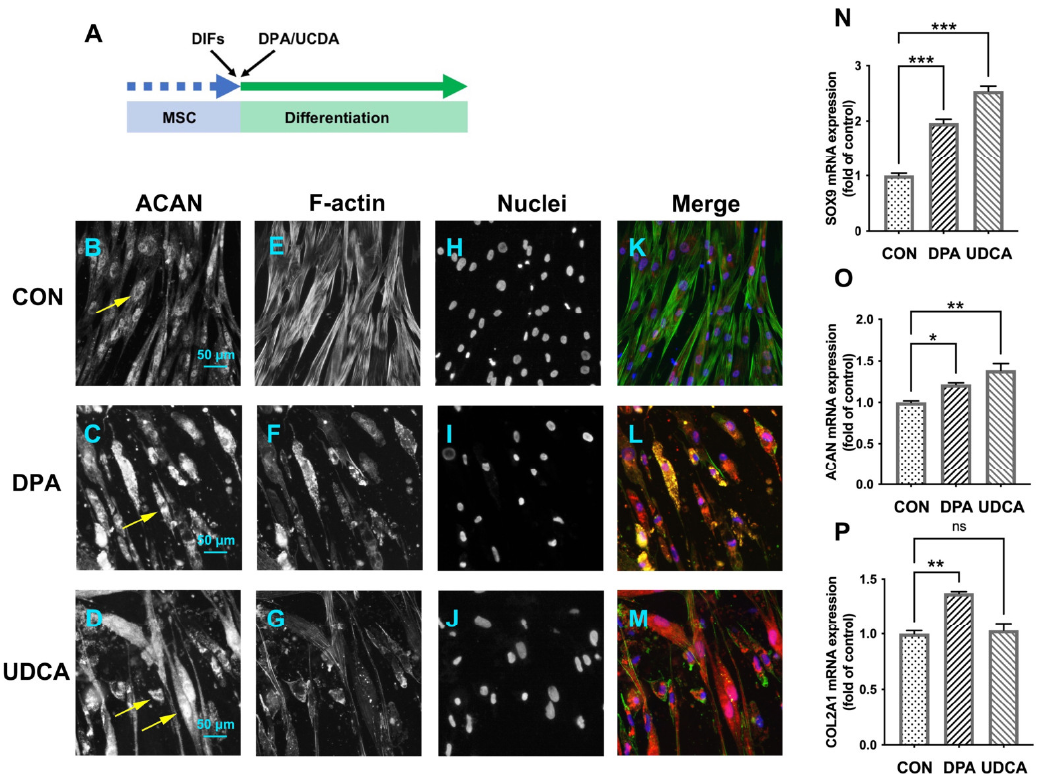
Figure 4. The effects of DPA and UDCA on chondrogenic differentiation. DPA and UDCA were separately administrated during the entire process of chondrogenic differentiation as indicated in ( A ). The distribution of proteoglycan aggrecan (ACAN, red) is revealed with immunofluorescence; F-actin (green) and nuclei (blue) are counterstained with phalloidin and DAPI, respectively. The immuno-positive signal of ACAN (arrows) is weak and restricted within the nucleus in the control (CON) group ( B , H ) and is strong and located in the cytoplasm and nucleus in both the DPA group ( C , I ) and UDCA group ( D , J ). F-actin is rearranged during the chondrogenic differentiation; i.e., it displays a sharp image after phalloidin staining in the CON group ( E ) and fades in both the DPA ( F ) and UDCA ( G ) groups. ( K,L,M ) show the merge images. The scale bar represents 50 μm. The mRNA expression levels of the SRY-related high mobility group-box gene 9 (SOX9, ( N )), ACAN ( O ), and type II collagen (COL2A1, ( P )) in the CON, DPA, and UDCA groups are quantified. The data are presented as mean ± SEM (n = 3). ns indicates no significance ( p > 0.05); * p < 0.05, ** p < 0.01, *** p < 0.001.